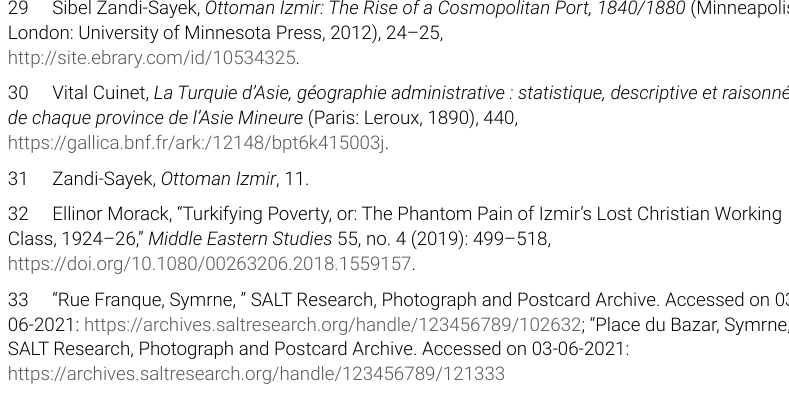
with growing number of immigrants from all over the Empire as well as from outside the imperial borders. 29 According to the official registers drawn up in 1890, Muslims constituted 44% of Smyrna’s residents, fol- lowed closely by Orthodox-Greeks with 26%, foreigners (immigrants mostly from Europe) with 19% and a roughly equal proportions of Jews and Armenians. 30 This plural social make-up was reflected in the city’s physi- cal organization. Residential neighborhoods bore testament to this diver- sity. Greek, Muslim, Armenian, Jewish and ‘Frankish’ ( frenk , i.e. European) neighborhoods were interlocked with one another. 31 The commercial boom resulted in high demand for wage labor. The industrial workforce in the city was fulfilled in high majority by ‘Rum’ (Greek Orthodox) people and by low percentage of Armenians, Jews, and later on by Muslim. The agricultural industries mostly employed seasonal workers during the har- vest. For instance, fig sorting and packing required three months of work per year and was done mostly by female seasonal workers. 32 [Figs. 6-7] 33